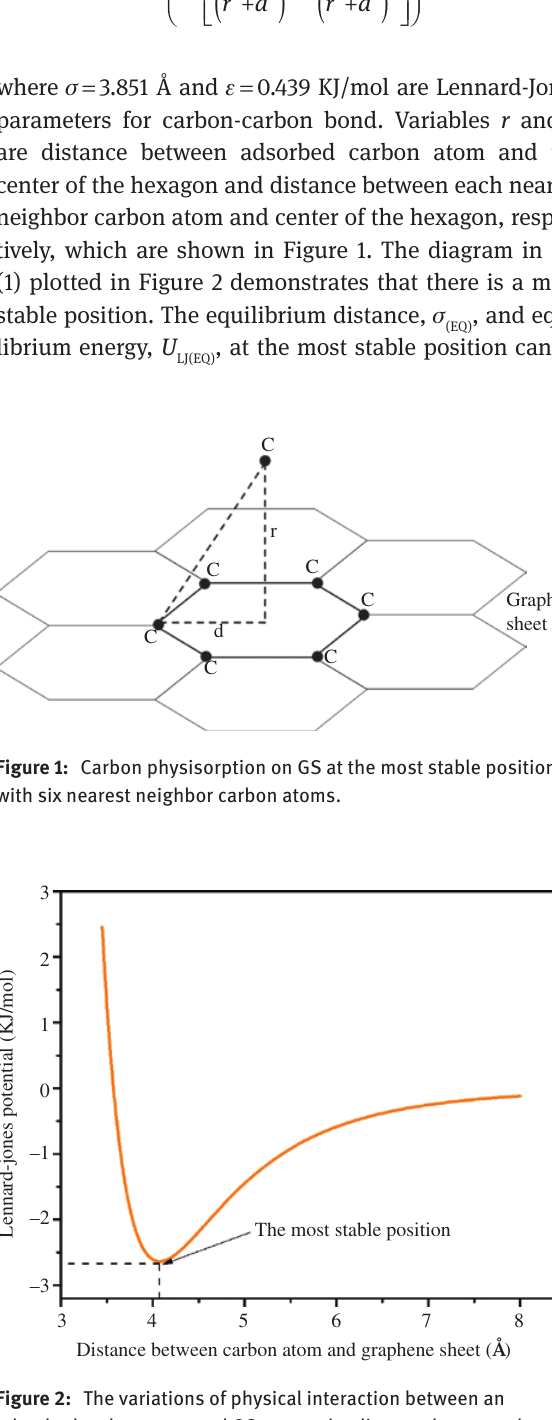
Figure 3: Schematic of growth mechanism of 3D G-CNT hybrid